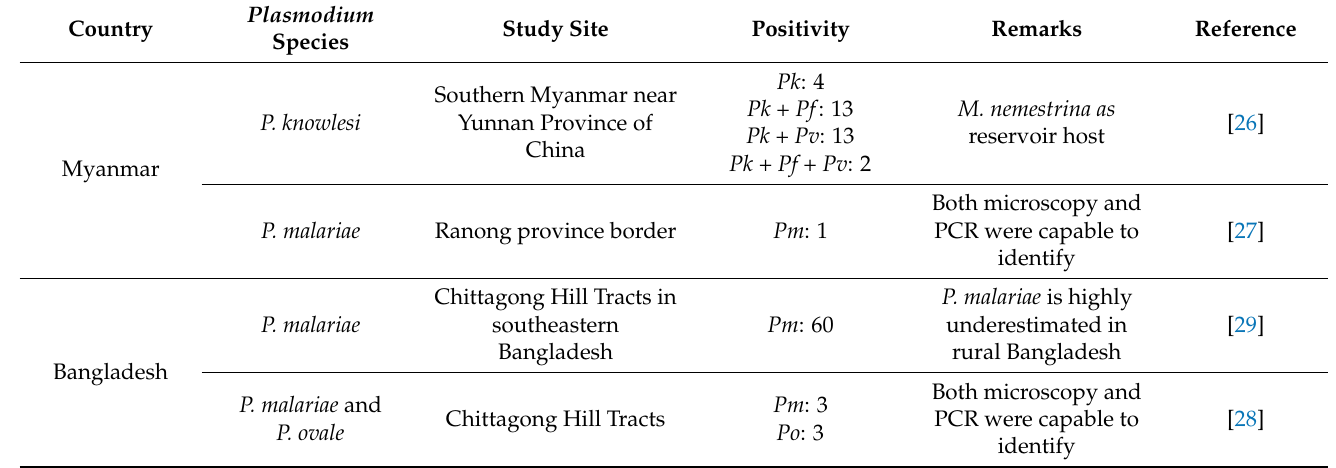
Figure 5. ( A ): Malariometric indices (API, SPR, SFR) in Lawngtlai District of the State of Mizoram from 2017 to 2020; ( B ) monthly total malaria cases from 2017 to 2020 (source: State Vector-Borne Diseases Control Programme, Mizoram). Note: API: annual parasite index, SPR: slide positivity rate, SFR: slide falciparum rate). Table 3. Prevalence of Plasmodium malariae and other neglected Plasmodium species in India and the adjoining countries bordering the northeastern states.